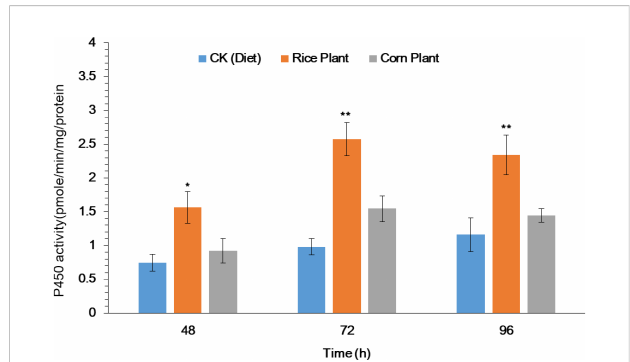
FIGURE 2 Activity of P450 enzyme in midguts of the fourth-instar larvae of FAW after feeding on rice and corn plants. The data were expressed as the means ± SE. Treatments were compared using Duncan ’ s multiple range test. * and ** represent P < 0.05 and P < 0.01, respectively.